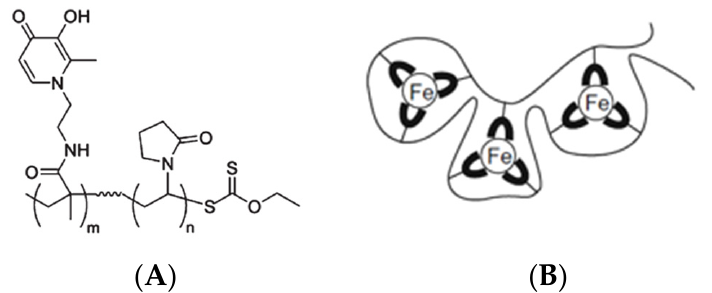
Figure 1. Schematic structure ( A ) of the iron chelator, DIBI ( m = 9, n = 62) and its iron binding capacity ( B ).